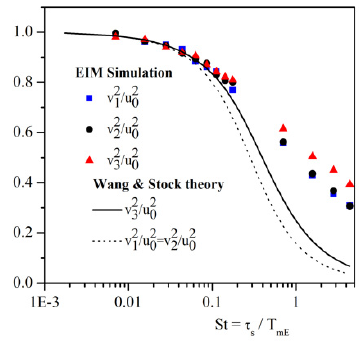
Figure 11. Normalized variance of particle velocity (g ≠ 0).